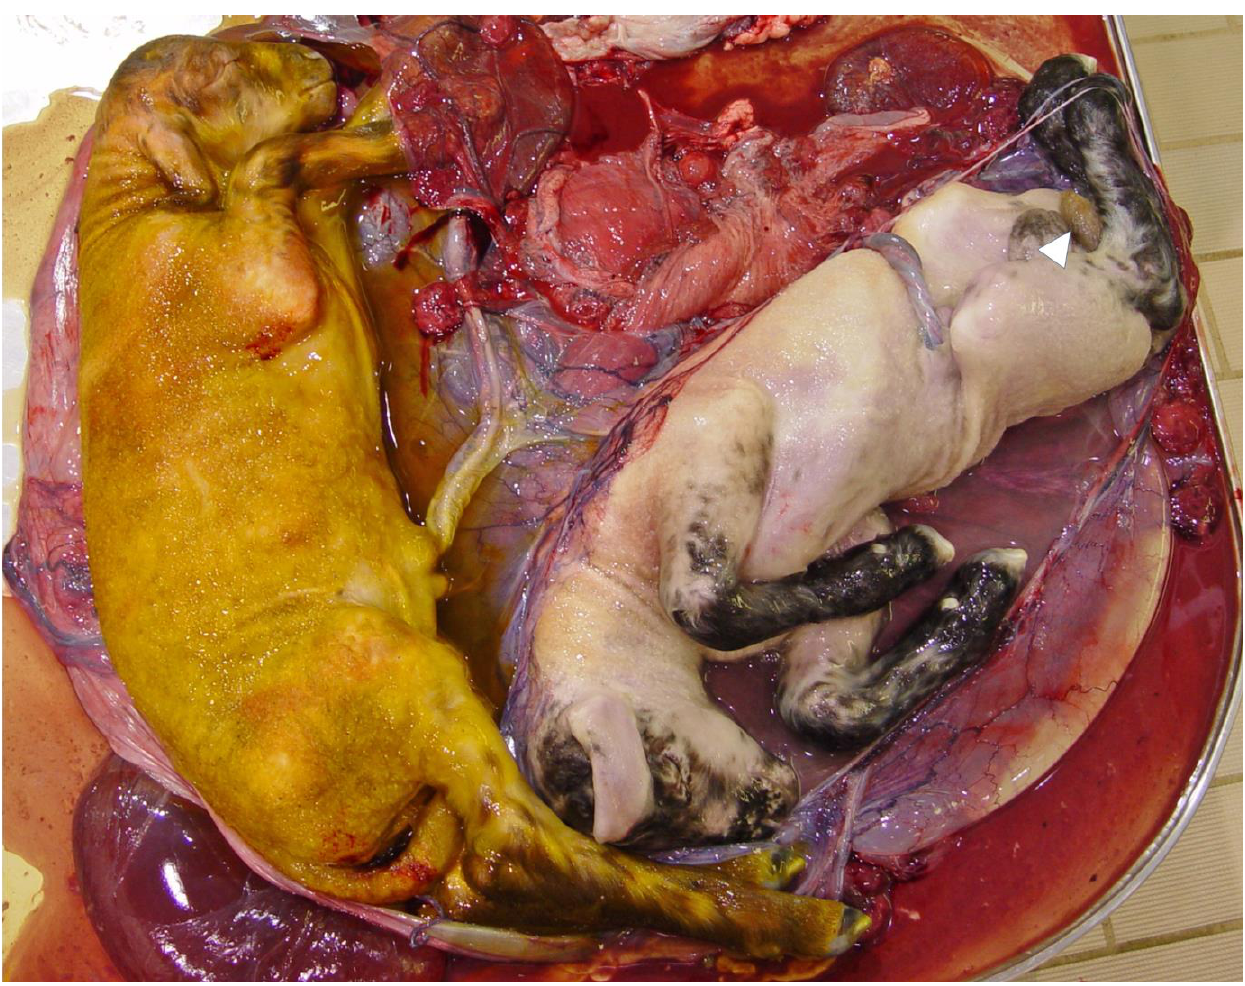
Figure 1. Postmortem inspection of the uterus of a ewe with twin gestation and fetuses that suffered hypoxia. Diffuse severe greenish meconium staining throughout the fetal skin of the left fetus). Large meconium particles expelled from the intestine are on the skin of the second fetus (arrowhead). Courtesy Dr. Carolyn Legge, Atlantic Veterinary College.